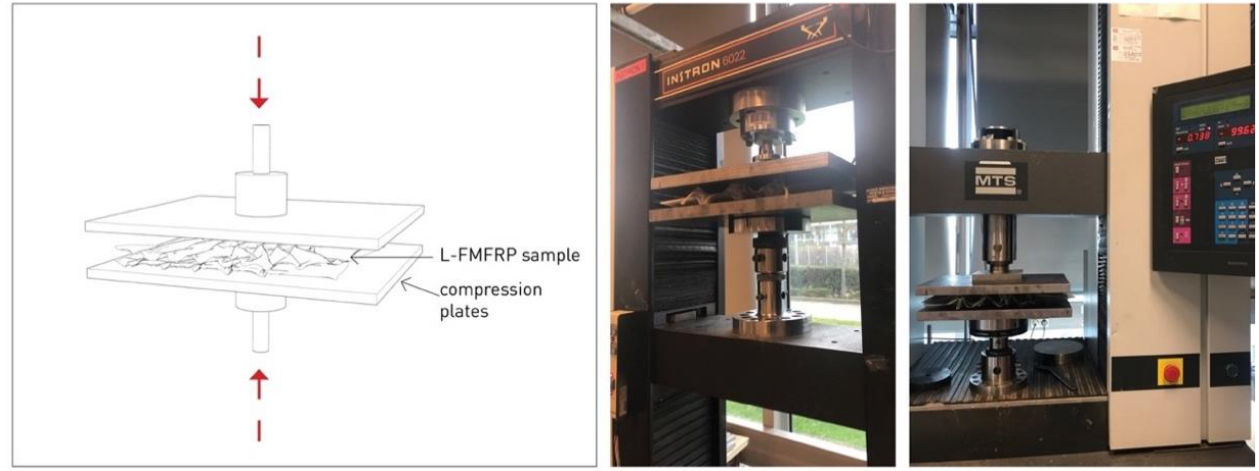
Figure 4. Experiment setup: sample positioned between two steel levelling plates.